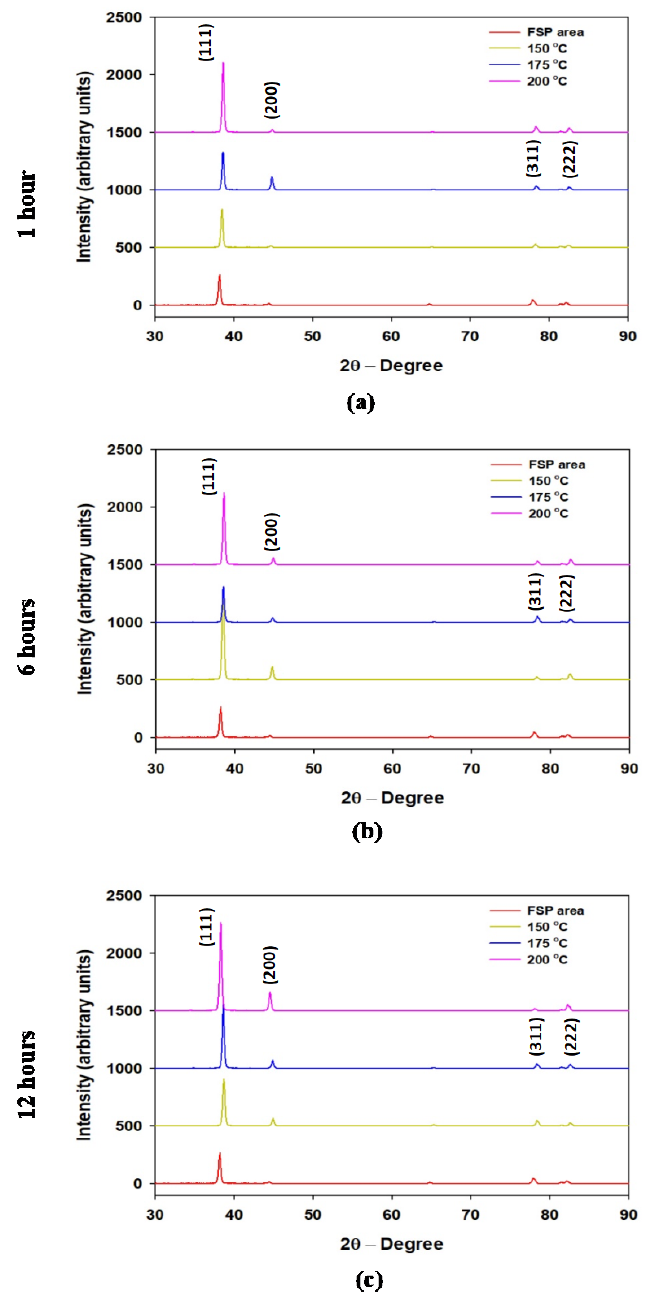
Figure 12. XRD patterns of AA6082 samples aged for: ( a ) 1 h; ( b ) 6 h and ( c ) 12 h.